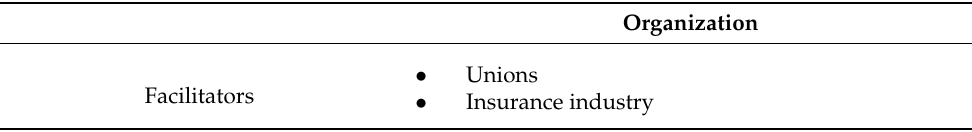
Table 5. Summary of organization category outcomes.